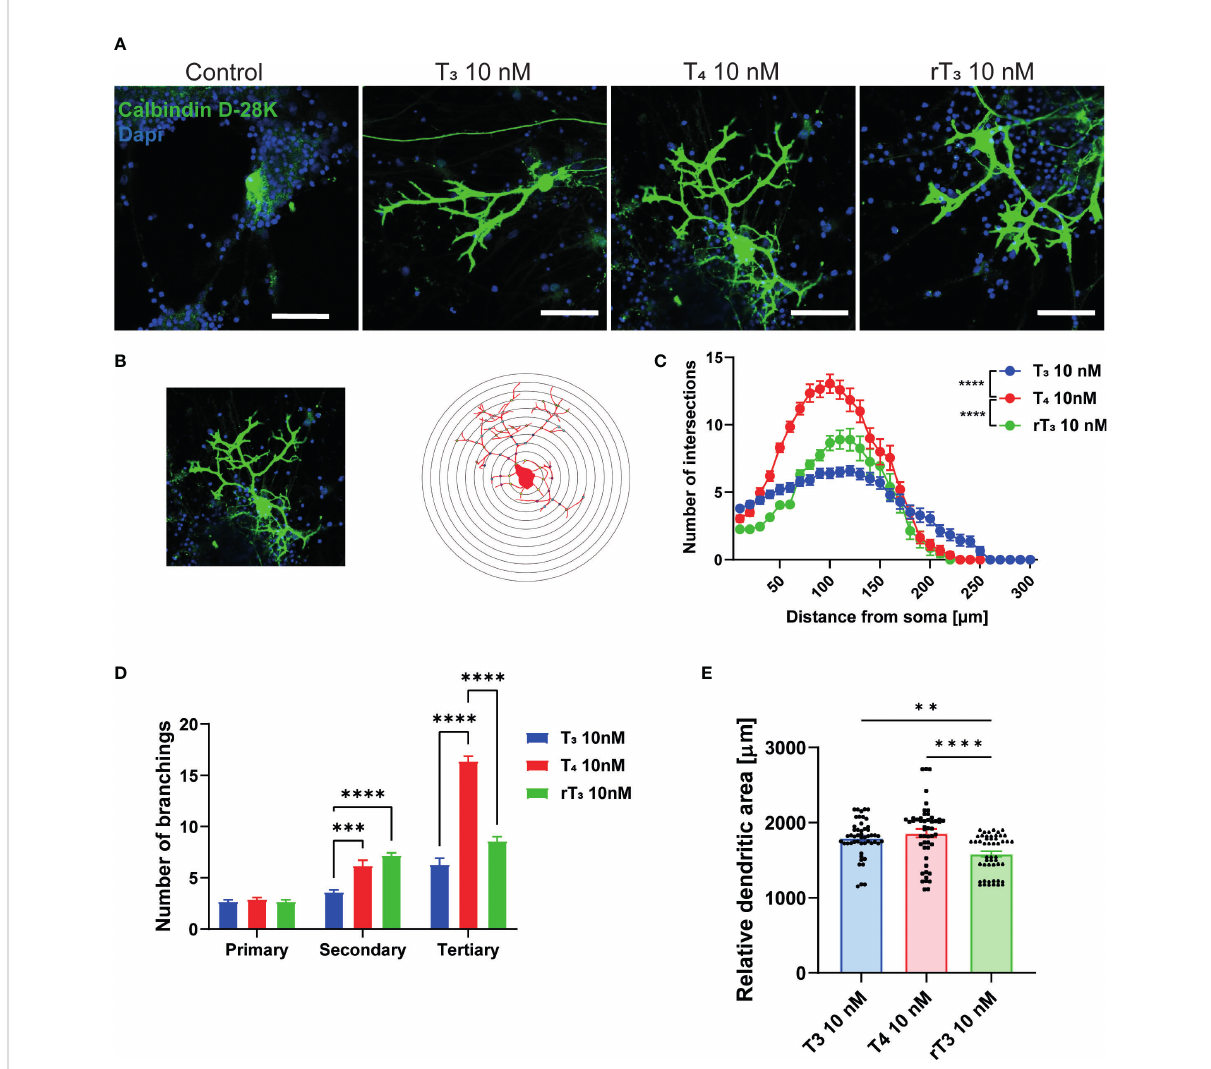
FIGURE 1 Effect of TH on Purkinje cell dendrite arborization in primary cerebellar culture. Cerebellar cells were cultured for 17 days, followed by an immunocytochemistry analysis of Purkinje cells with Calbindin D-28K (green) and DAPI (blue). (A) Representative photomicrographs showing the effects of TH on the morphology of Purkinje cells. (B) Schematic diagram of Sholl analysis. (C) Quantitative analysis of the effect of TH on the number of dendrite intersections at each concentric circle by Sholl analysis. (D) Quantitative analysis of the effect of TH on the number of secondary and tertiary dendrites of Cerebellar Purkinje cells. (E) Changes in the dendritic areas of Purkinje cells following TH treatment. ImageJ Fiji software (NIH) was used to quantify the dendritic area of Purkinje cells and Sholl analysis. Bars indicate 50 m m. Data are shown as the mean ± SEM and representative from at least three independent experiments. **** p < 0.0001 and ** p < 0.001 indicate statistical signi fi cance according to two-way or one-way ANOVA continued with post hoc Turkey test. See Supplementary Table